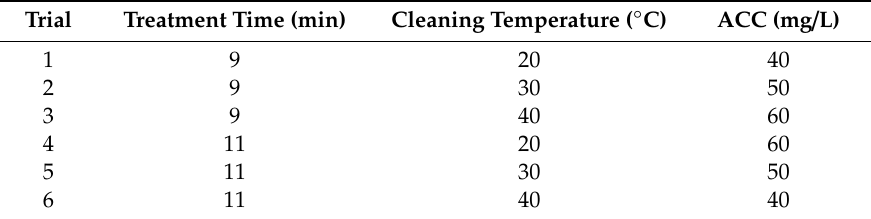
Table 2. Six trials with di ff erent parameters used to validate the